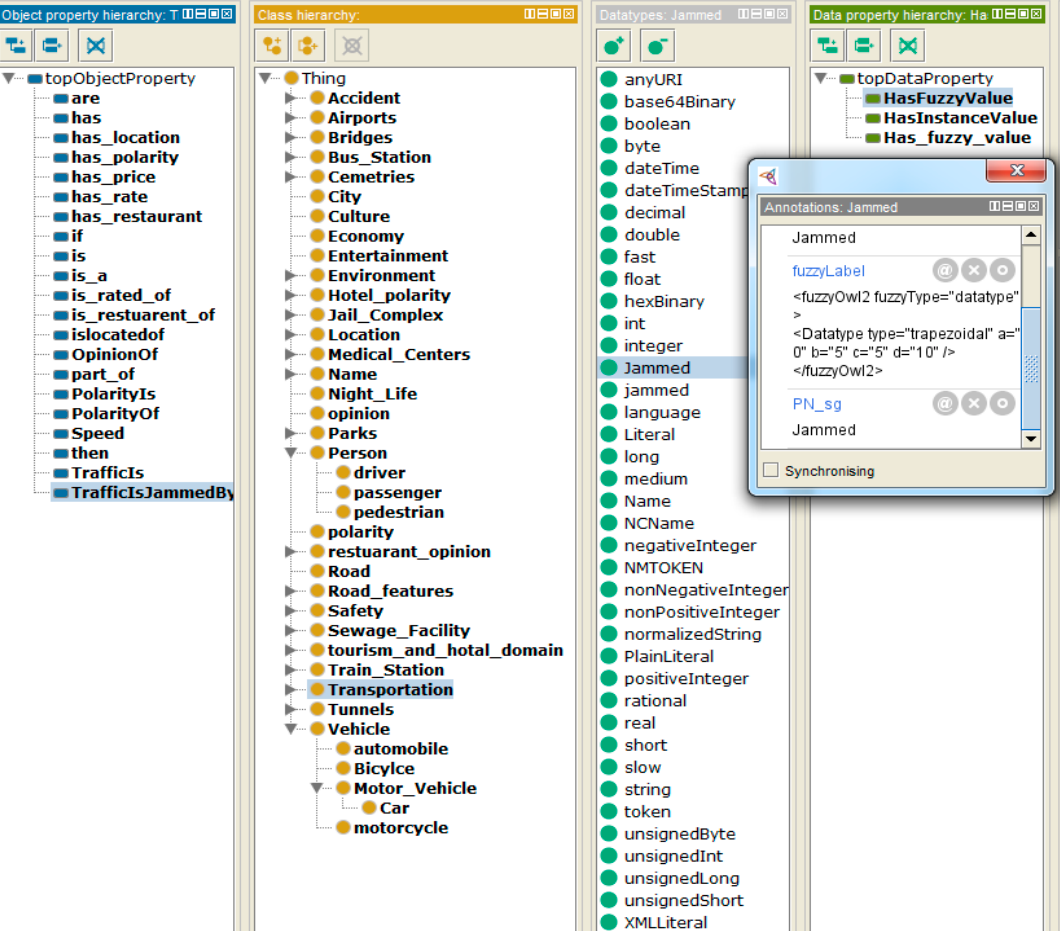
Figure 4. Ontology of transportation features.